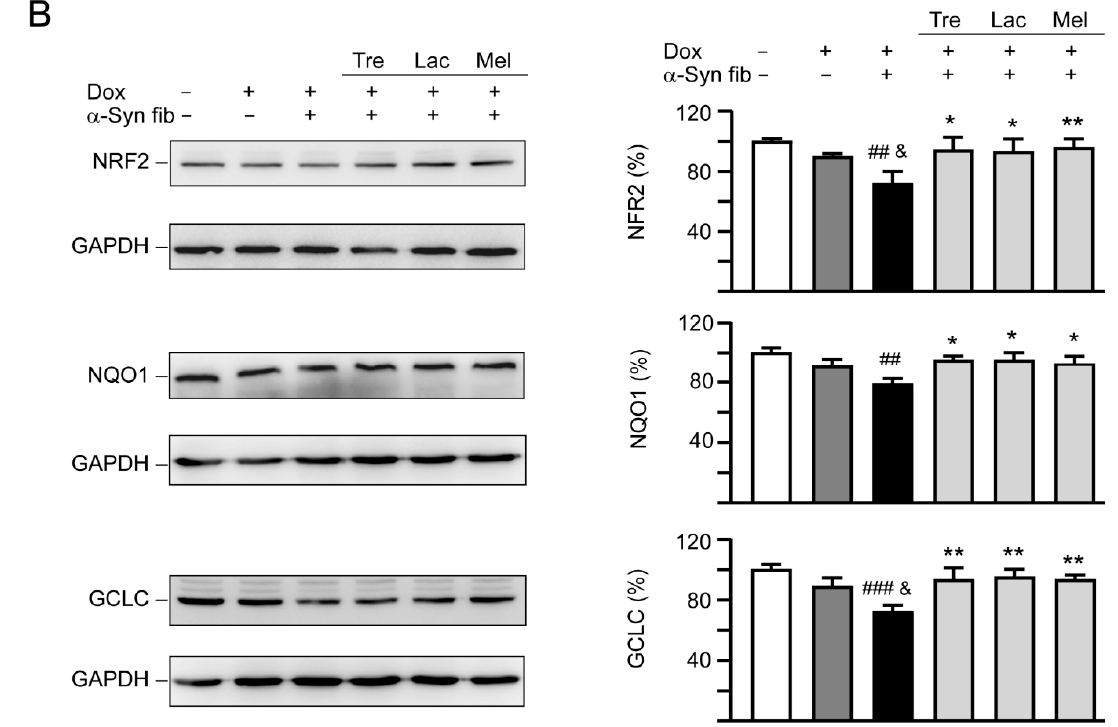
Figure 7. Autophagy induction and oxidative stress reduction of tested disaccharides in SNCA-GFP-expressing SH-SY5Y cells. On day eight, TPA-di ff erentiated SH-SY5Y cells were pretreated with 100 µ M trehalose, lactulose, or melibiose for 8 h followed by induction of SNCA-GFP expression and addition of α -synuclein fibrils for six days. Relative ( A ) LC3-I and LC3-II and ( B ) NRF2, NQO1, GCLC protein levels were analyzed ( n = 3). GAPDH was included in immunoblot as an internal control. To normalize, expression level in cells uninduced and without preformed fibril addition ( − Dox / − α -Syn fibrils) was set at 100%. p values: comparisons between − Dox / − α -Syn fibrils vs. + Dox /+ α -Syn fibrils ( ## : p < 0.01, ### : p < 0.001), between + Dox / − α -Syn fibrils vs. + Dox /+ α -Syn fibrils ( & : p < 0.05, && : p < 0.01), or between + Dox /+ α -Syn fibrils-cells with and without disaccharide treatment (*: p < 0.05, **: p < 0.01; one-way ANOVA with a post hoc Tukey test).